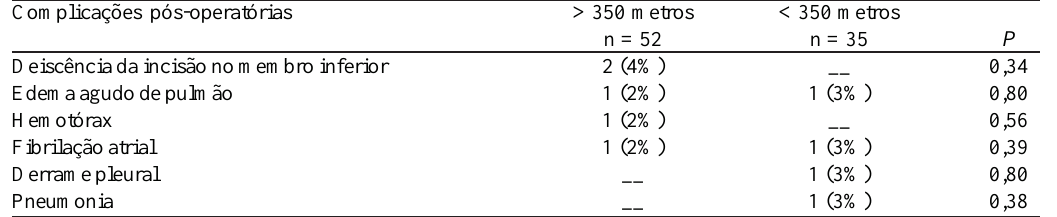
Tabela 4. Complicações